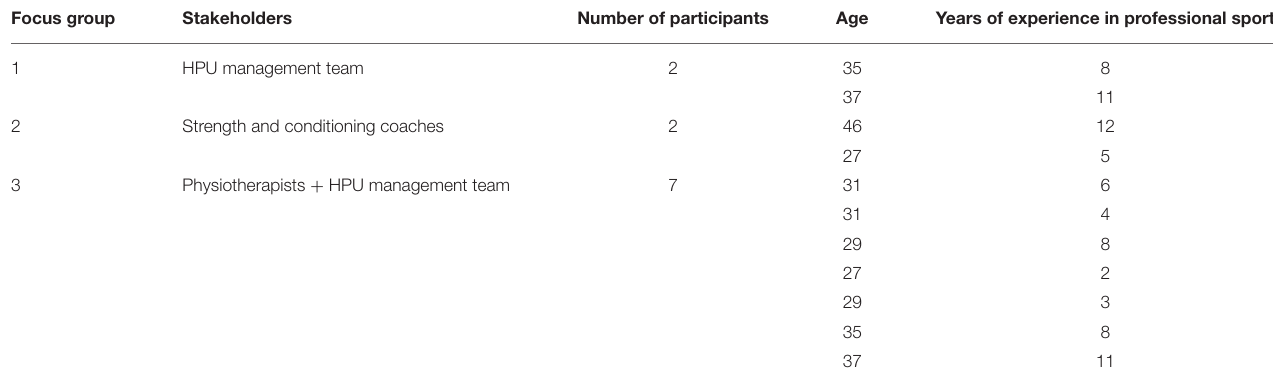
TABLE 6 | Participant characteristics (focus groups) for analyzing M2 decision process. Focus